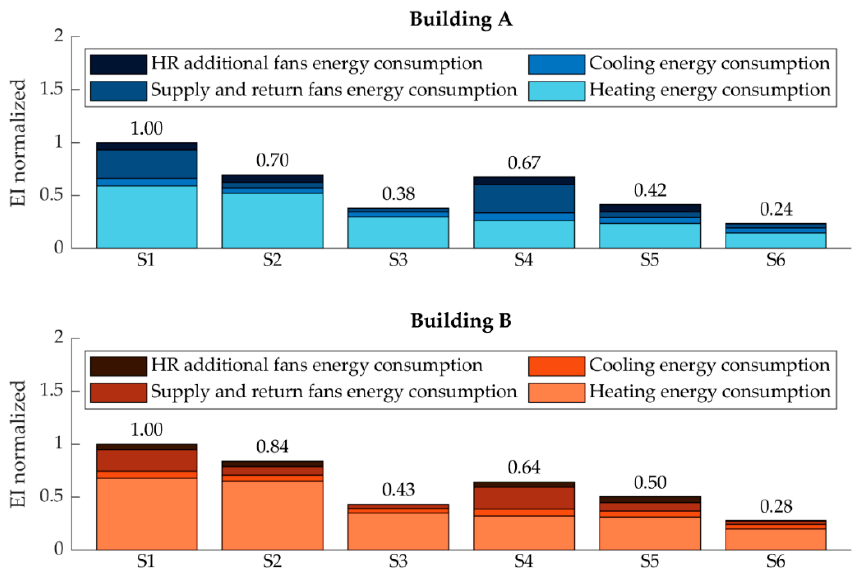
Figure 8. Comparison of the normalized energy intensities for the two buildings for the various control strategies.